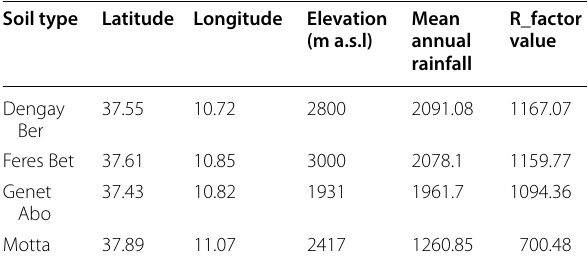
Table 2 Mean annual rainfall and R-value (computed from 20 years monthly data) Soil type Latitude Longitude Elevation (m